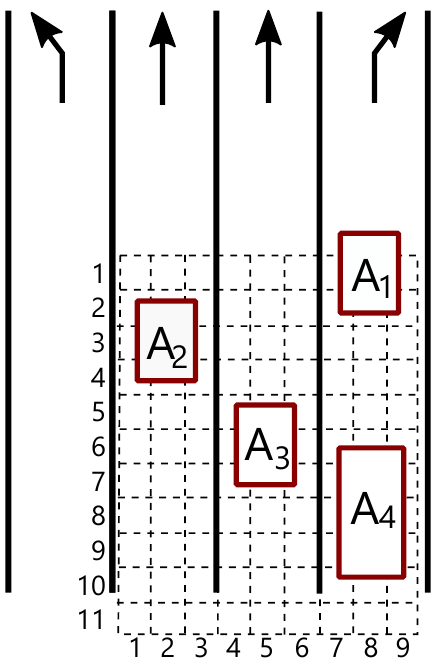
Figure 3. Lane shifting; grid view of vehicle A 3